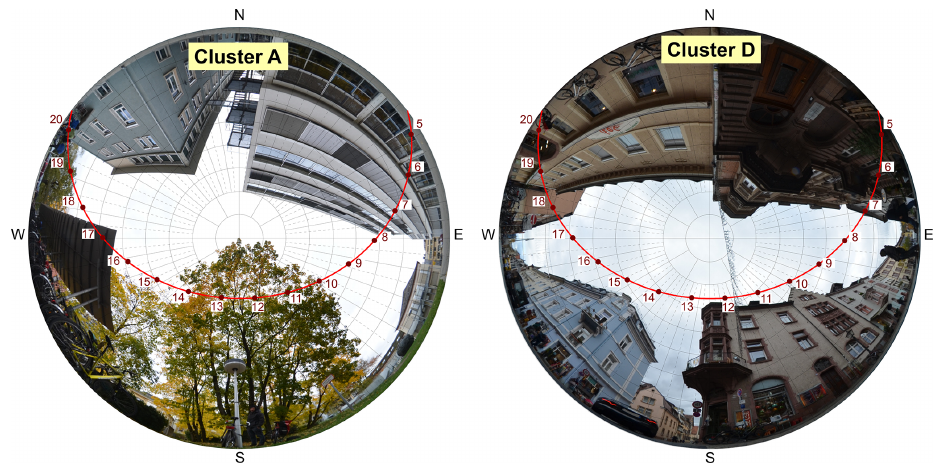
Figure 9. Sun path at cluster A and cluster D during the summer solstice, calculated from hemispherical photos by using RayMan (Matzarakis et al., 2007). The points and numbers indicate the position of the sun each hour (time zone UTC + 1), while the red line indicates the sun path over the day.